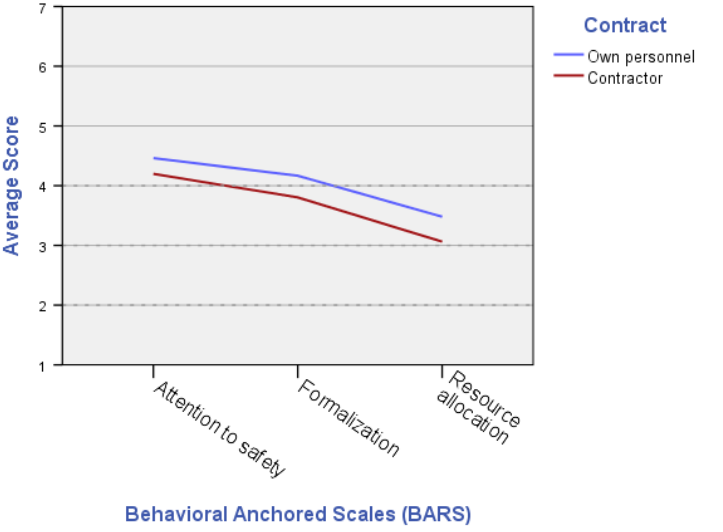
Figure 15. BARS averages by contractual relationship. Own staff score higher in emphasis on safety (Figure 16), formalization (Figure